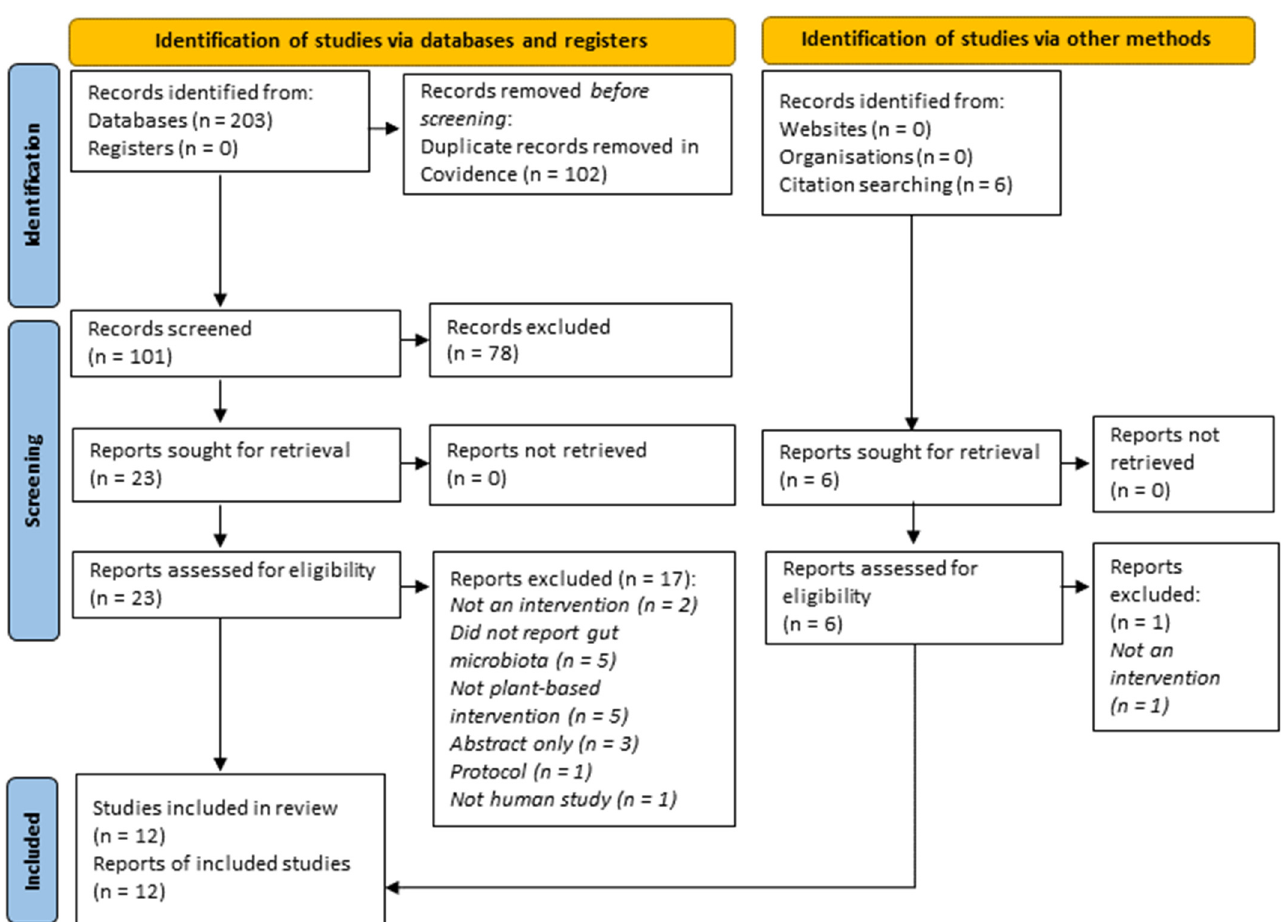
Figure 1. PRISMA 2020 flow chart detailing the study selection process.